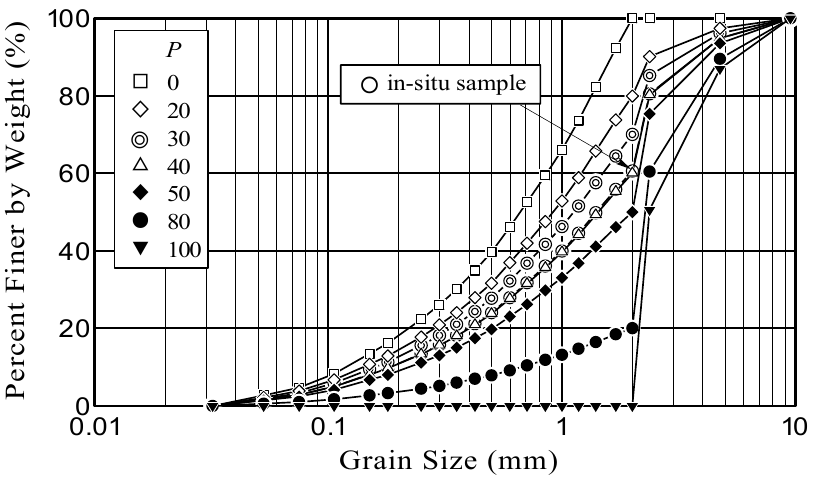
Figure 3. Grain-size distribution curves for samples used in 1D compression tests conducted by Ham et al. (2010) [20].